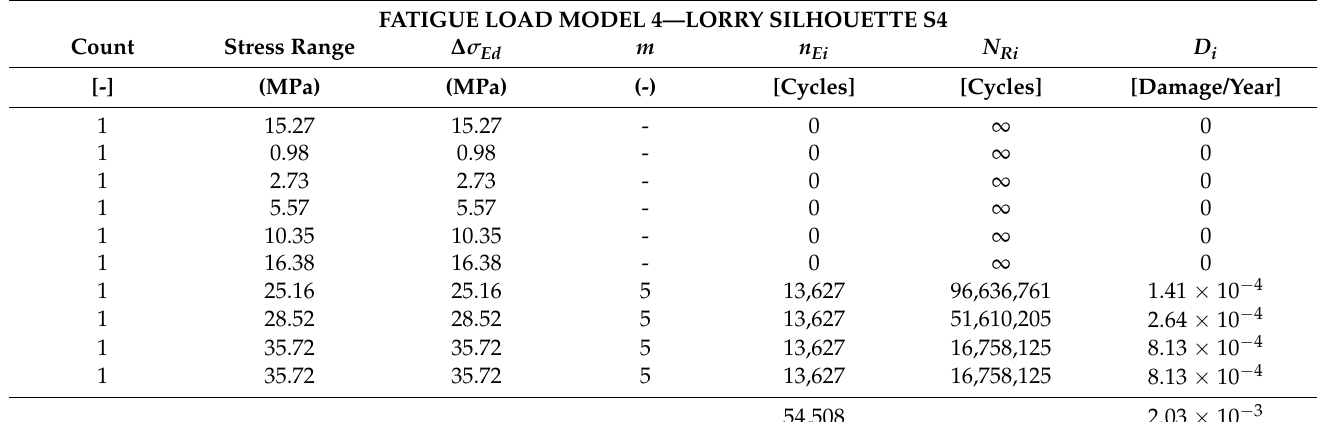
Table 7. Distinction of detail assessment: Rib-to-Plate—FLM4 S4.